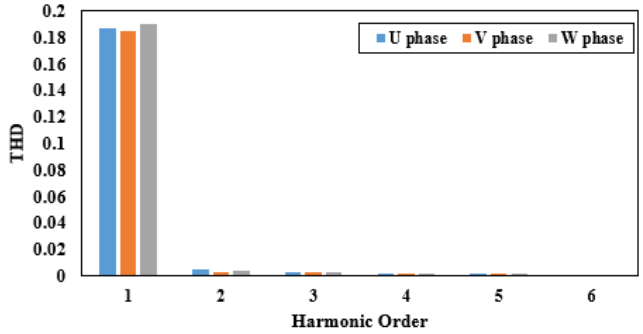
Figure 8. Frequency spectrum representation.